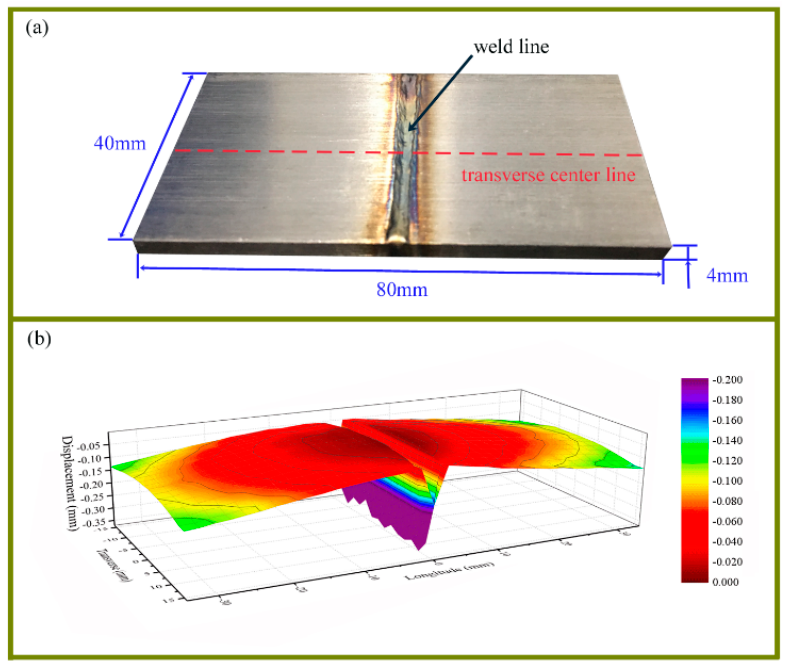
Figure 2. The welded 316L stainless steel and morphology of the bottom surface of case S1. ( a ) The welded part. ( b ) The morphology of the bottom surface.